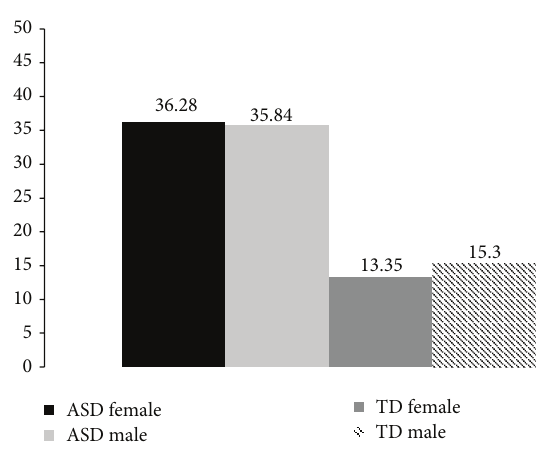
Figure 5: Mean scores on the total AQ for males and females of TD and ASD